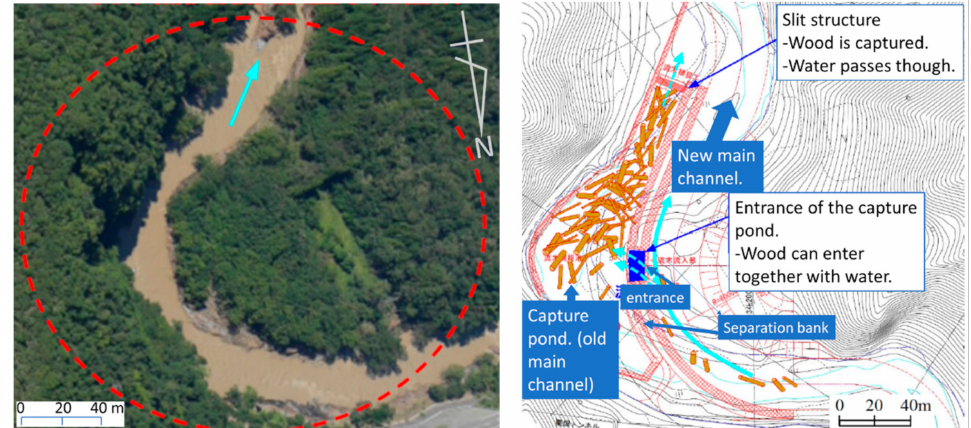
Figure 5. Planned site for driftwood capture facility in Omoto River, Iwate, Japan (( left ) aerial photograph, ( right ) schematic diagram of planned driftwood facility). Reproduced with permission from Kato et al., Experimental study on design of driftwood capturing facility in Omoto River; published in Advances in river engineering. JSCE, 2018 [3].